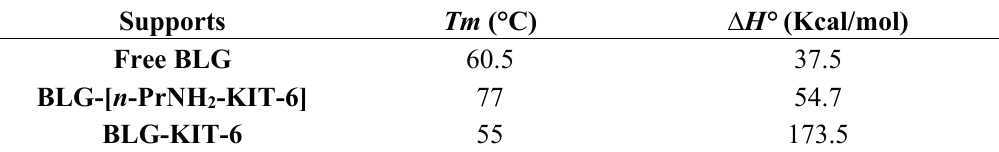
Table 2. Typical DSC results of free and immobilized